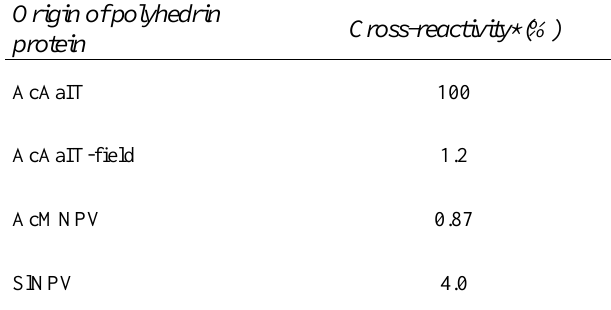
of AcAaIT/IC of 50 50